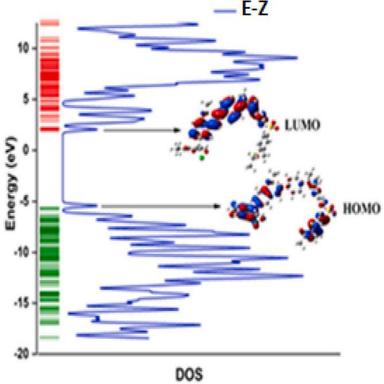
Density of state (DOS) and frontier molecular orbitals obtained from the TD-DFT for M-DSB.